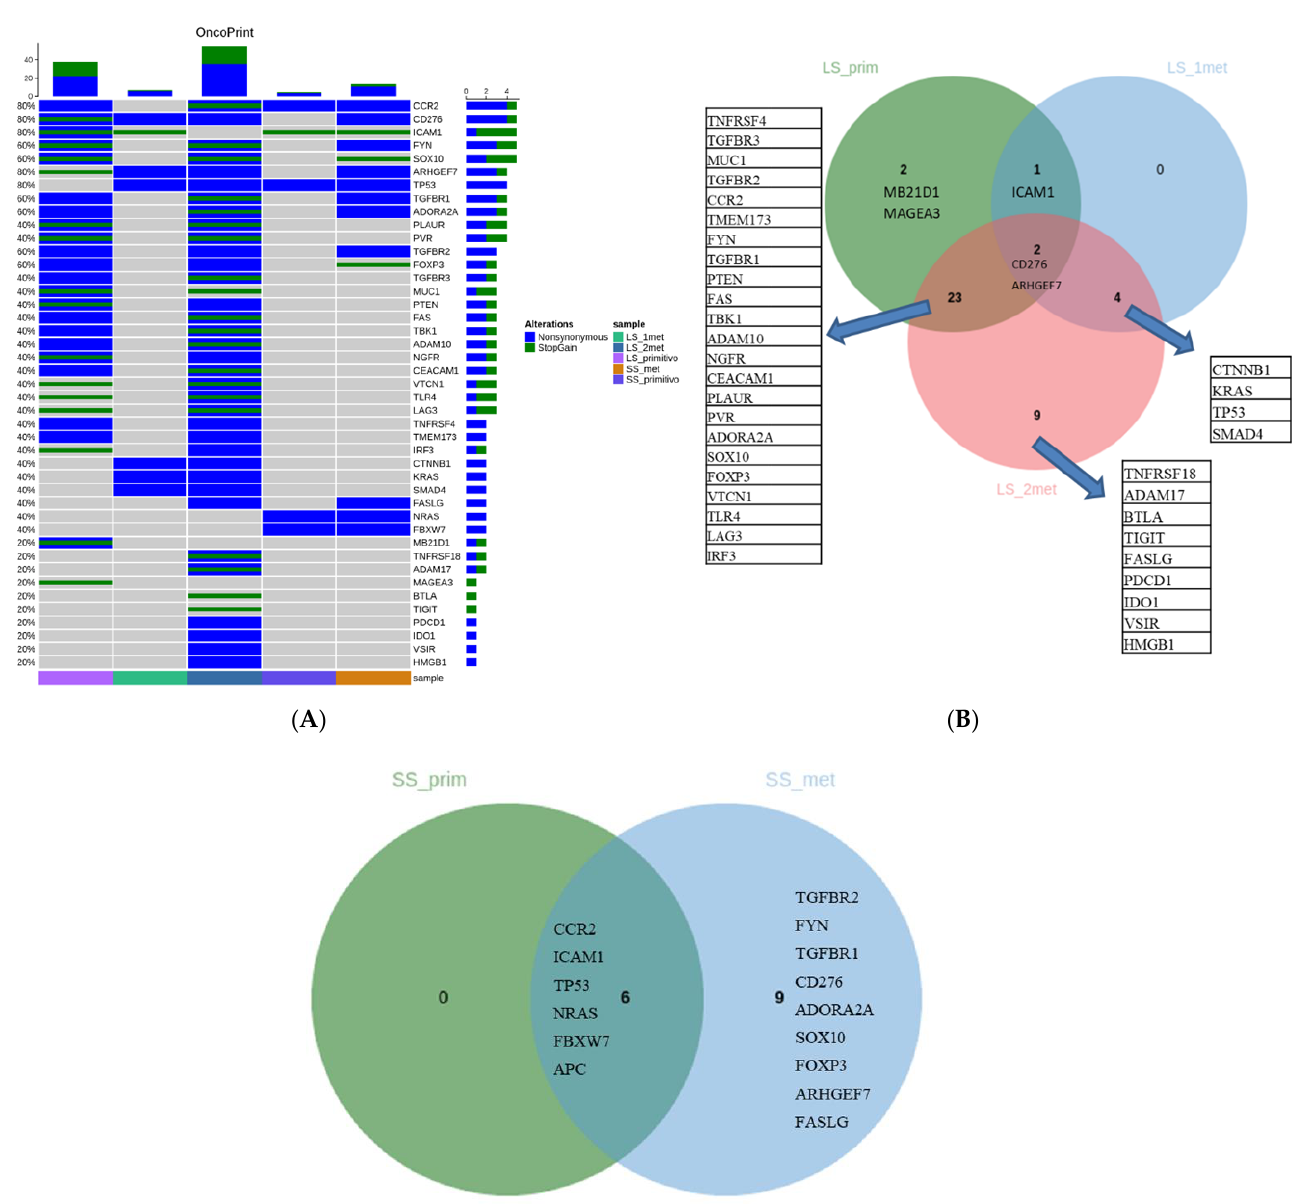
Figure 1. ( A ) Oncoprint including pathogenic alterations detected in the five analyzed samples. ( B ) Venn diagram of the alterations detected in the long survival samples (primary CRC and the two metastatic samples). ( C ) Venn diagram of the alterations detected in the short survival samples (primary CR Cand metastatic samples). LS_prim: primary tumor of the long survival case; LS_1met, LS_2met: metastatic samples of the long survival case; SS_prim: primary tumor of the short survival case; SS_met: metastatic sample of the short survival patient.